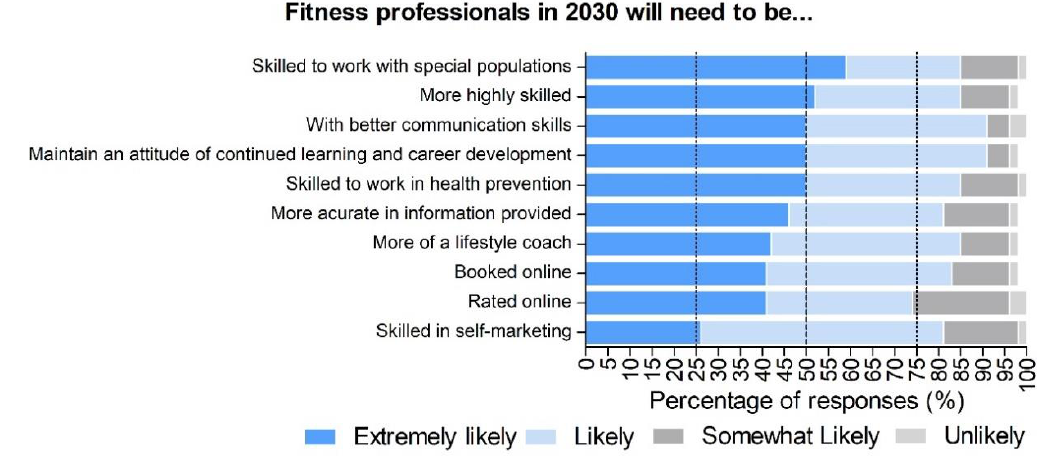
Figure 2. Levels of likeliness rated in percentages (%) by the experts ( n = 50) about how fitness places will be by 2030. In dark blue, extremely likely. In light blue, likely. In black grey, somewhat likely. In light grey, unlikely.